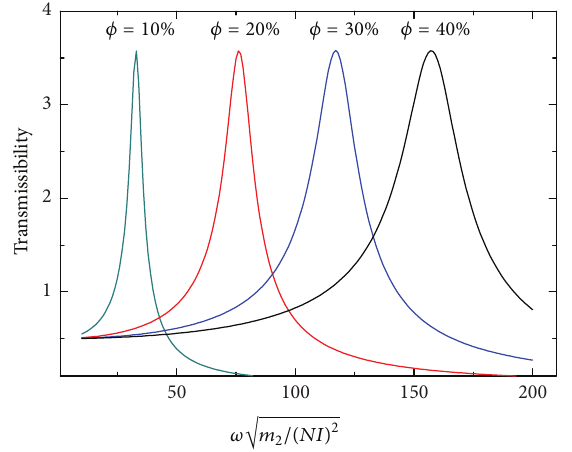
Figure 8: The impact of different volume fractions on the transmis-